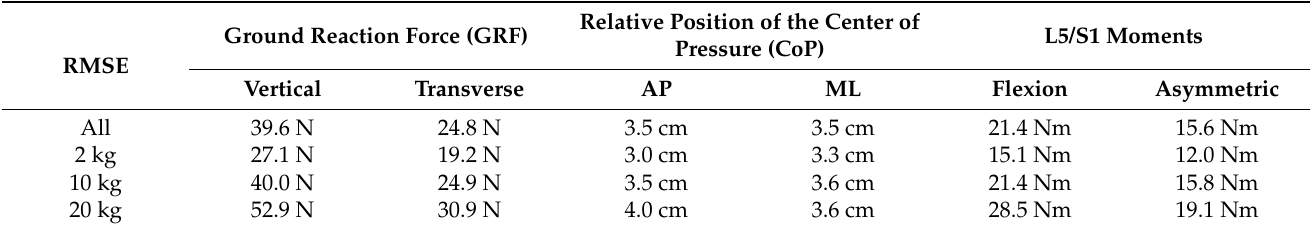
Table 1. RMSE between OMC + PF and IMC for the GRF, relative position of the CoP, and L5/S1 moments curves during the transfer phase.